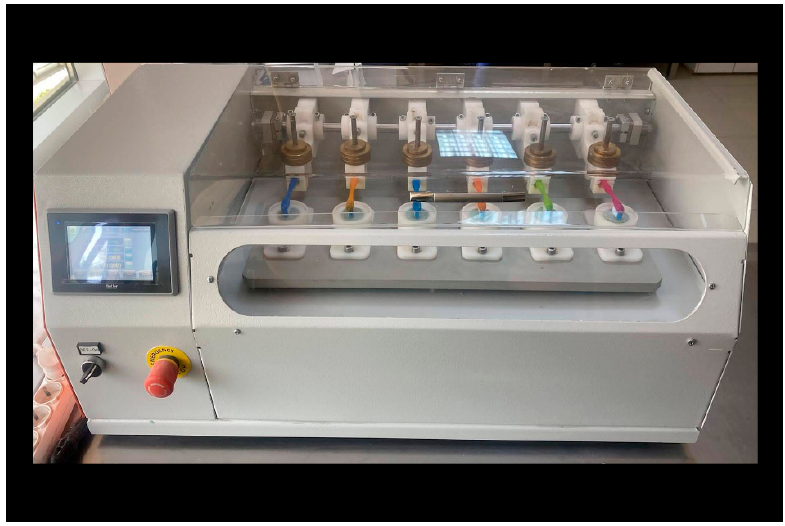
Figure 2. Toothbrushing simulation device used in the study. Surface roughness (R a ) values of all specimens were measured using a contact pro- filometer (Perthometer M2; Mahr, Göttingen, Germany) with a 0.01 mm resolution, 0.8 mm interval (cut-off length), 5.5 mm transverse length, and 1 mm/s stylus speed. For each speci- men, measurements were performed with the instrument’s diamond stylus (NHT-6) 3 times under constant pressure, and the mean R a values were calculated and recorded in µ